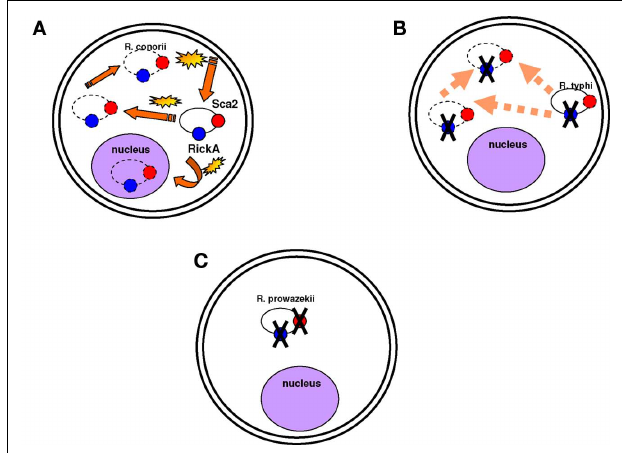
FIGURE 3 | Motility is not necessarily a virulence factor. (A) Rickettsia conorii is mobile in the cytoplasm and in the nucleus and moves quickly. Actin-based motility is associated with the Sca2 and RickA proteins (represented in red and blue circles respectively).Yellow stars are to demonstrate that the bacterium moves fast in the cytoplasm; dotted lines are to show that the bacterium can be found anywhere in the cytoplasm and even in the nucleus. (B) Rickettsia typhi is also mobile in the cytoplasm, but it moves less quickly than R. conorii . Its mobility is associated with the Sca2 protein. (C) R. prowazekii is completely immobile in the cytoplasm.The Sca2 and RickA proteins are